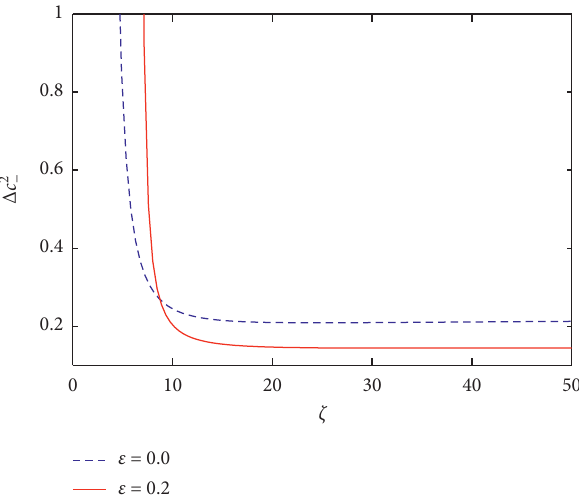
Figure 2: Plots of the minus quadrature variance (equation (47)) versus ζ for κ � 0 . 8, A � 2 . 5, and r � 0 . 75 and for different values of ε .